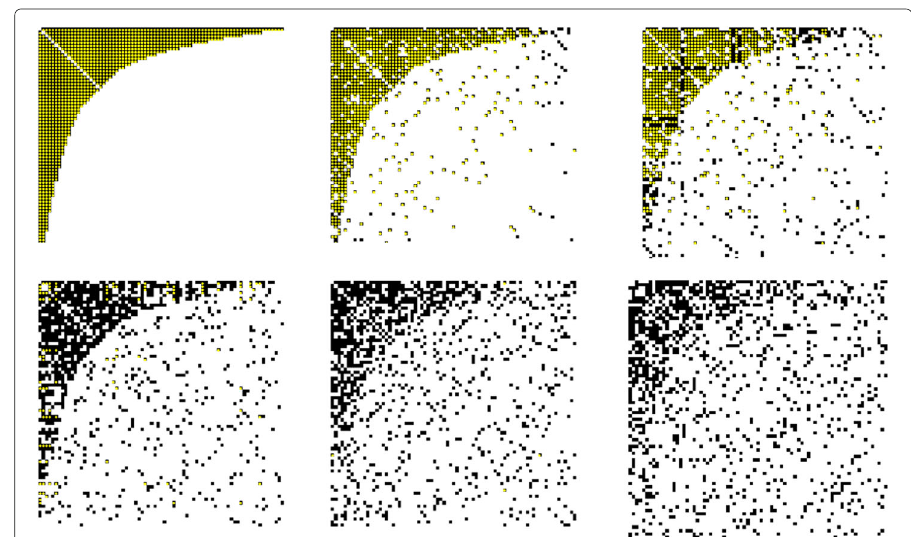
Fig. 2 Adjacency matrices of the unipartite benchmark graphs with edge rewiring: ρ rew = 0.0 (top left), = 1.0 (top center), ρ = 2.0 (top right), ρ = 3.0 (bottom left), ρ = 5.0 (bottom center), ρ rew rew rew rew = 7.0 (bottom right) for α = 0.45. The vertices that are counted towards to the nested component by ρ rew NESTLON are indicated by a yellow